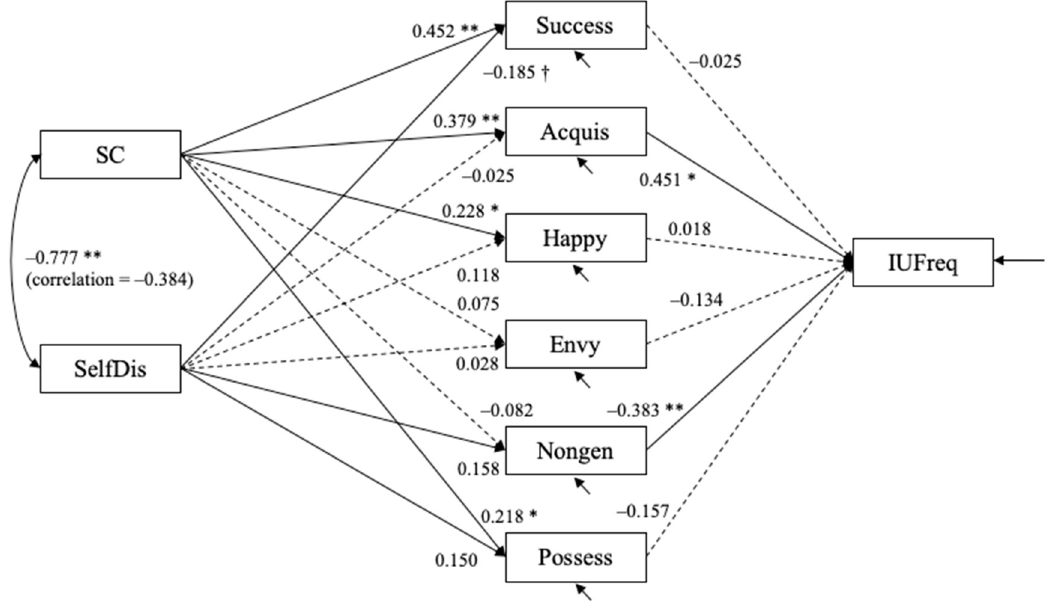
Figure 4. Study 1: Estimated structural equation model with objective measure of Instagram usage ( N = 108).